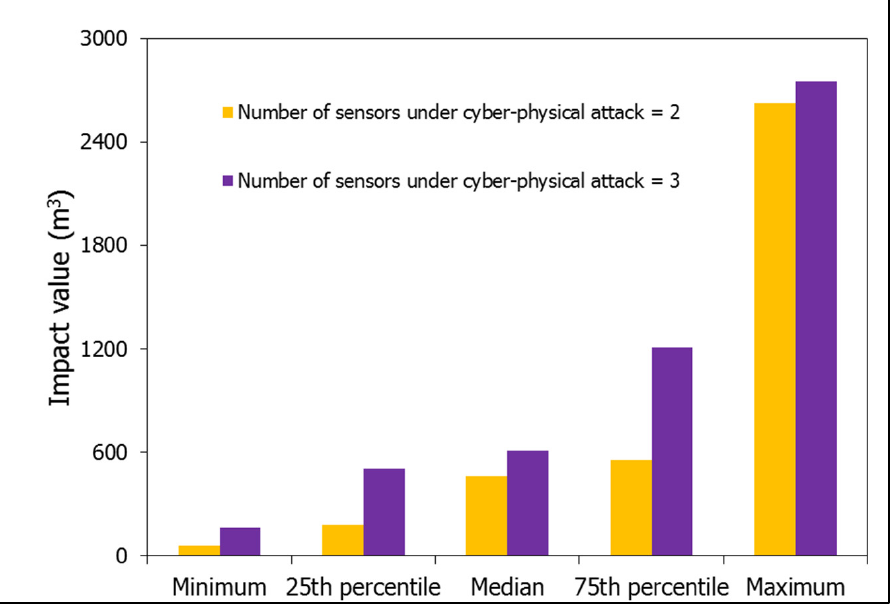
Figure 8. Impact values corresponding to the scenario under which two and three WQ sensors of the designed OCMS with η total = 6 is